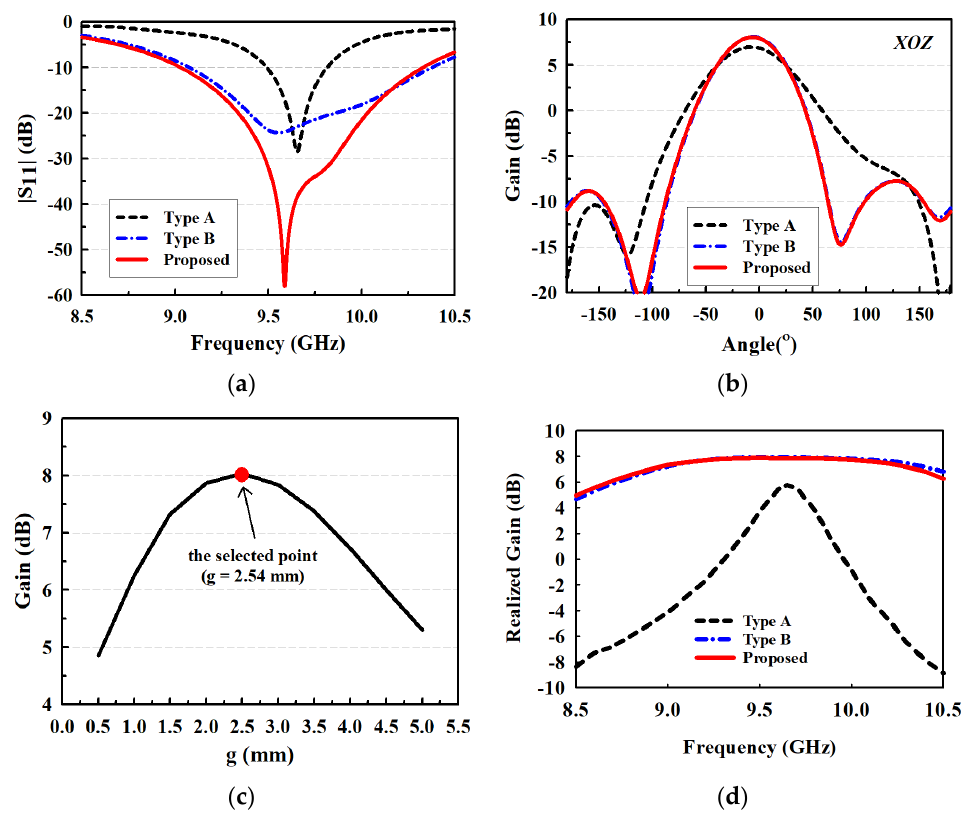
Figure 3. Simulation results of three different radiating elements showing ( a ) |S 11 |, ( b ) gains at 9.65 GHz ( c ) gain versus the air-gap width between the two substrates at 9.65 GHz and ( d ) realized gain variation.